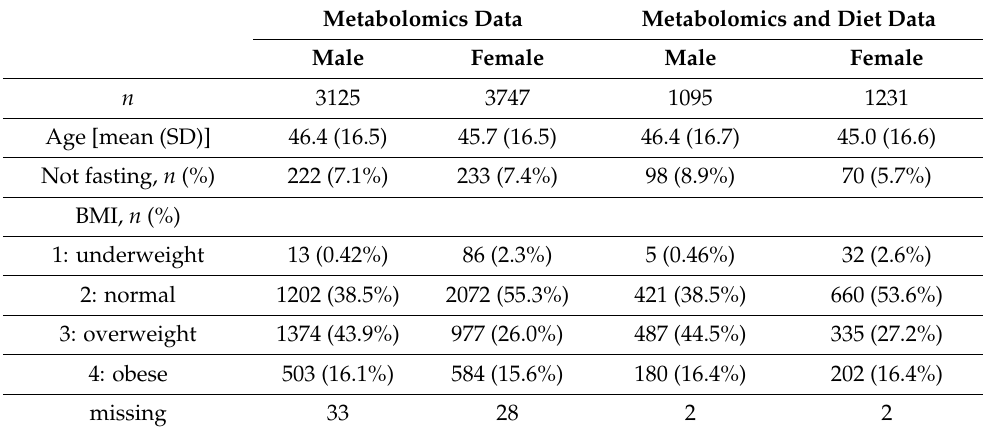
Table 1. Demographic characteristics of the study participants included in the